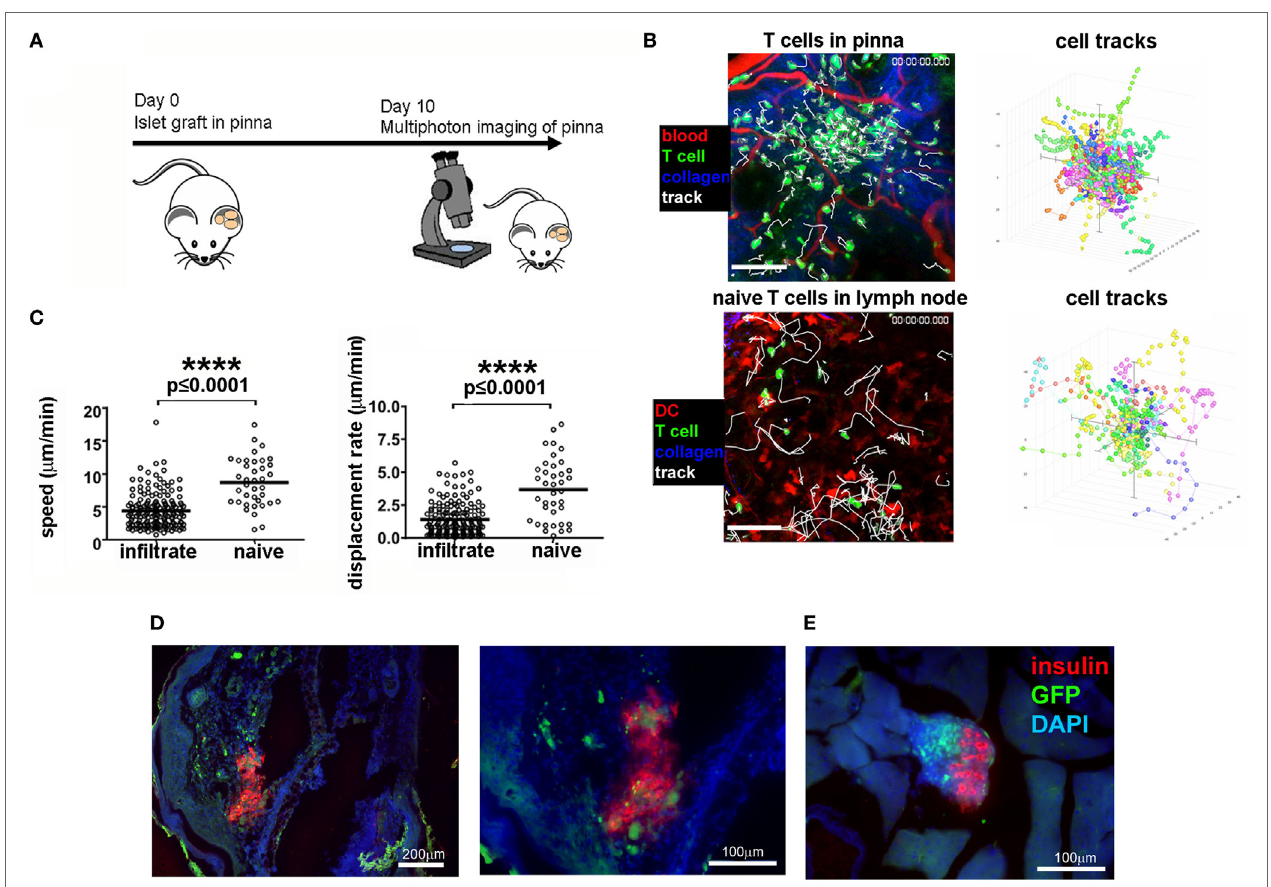
FigUre 2 | Imaging of T cell infiltration in NOD- scid islets transplanted into the pinna of the ear of a CD2-GFP NOD recipient. (a) On day 0, islets were isolated from a NOD- scid mouse and grafted into the pinna of a CD2-GFP NOD mouse. On day 10, the graft recipient was anesthetized and the graft imaged using multiphoton microscopy. (B) Multiphoton imaging showing either islet-infiltrating GFP + T cells (green) around a grafted islet in a 12-week old NOD recipient intact ear pinna (top panels), or naïve T cells moving in a lymph node (bottom panels). Scale bars represent 100 µm. The right-hand side flower plots demonstrate the movement of the T cells during imaging (B) , presented in graph form in (c) . After imaging, the pinna (D) and pancreas (e) were fixed and stained for insulin (red) and DNA stain DAPI (blue). T cells can be identified by green GFP signal. The selected images are representative of results from groups containing ≥ three